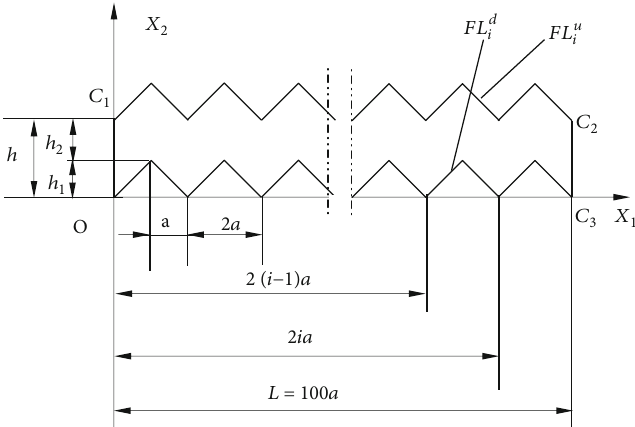
Figure 2: The computational domain of the rough fracture.